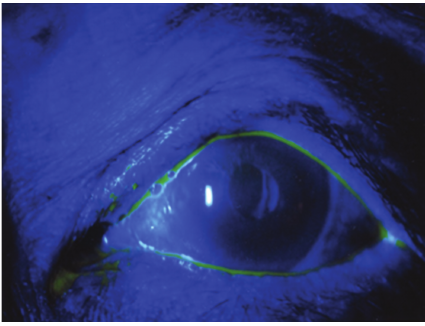
Figure 2: Fluorescein staining at the final consultation. Neither marked staining nor retention of fluorescein was